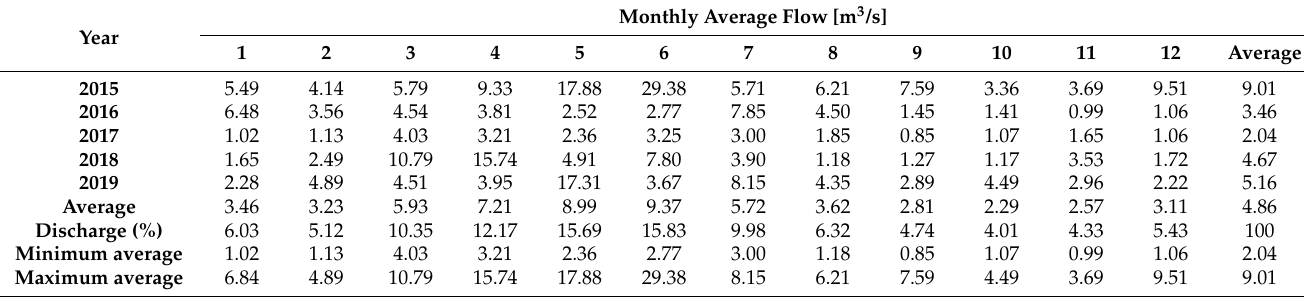
Table 3. Average flow rates of the Torysa river in the Presov hydrological station